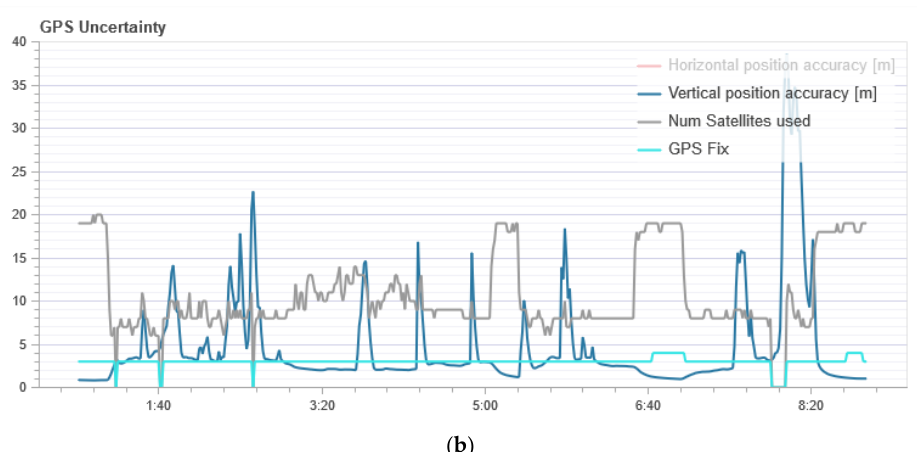
Figure 6. The state of the parameter indicating the number of GPS satellites: ( a ) In normal UAV flight mode; and ( b ) during a GPS attack.